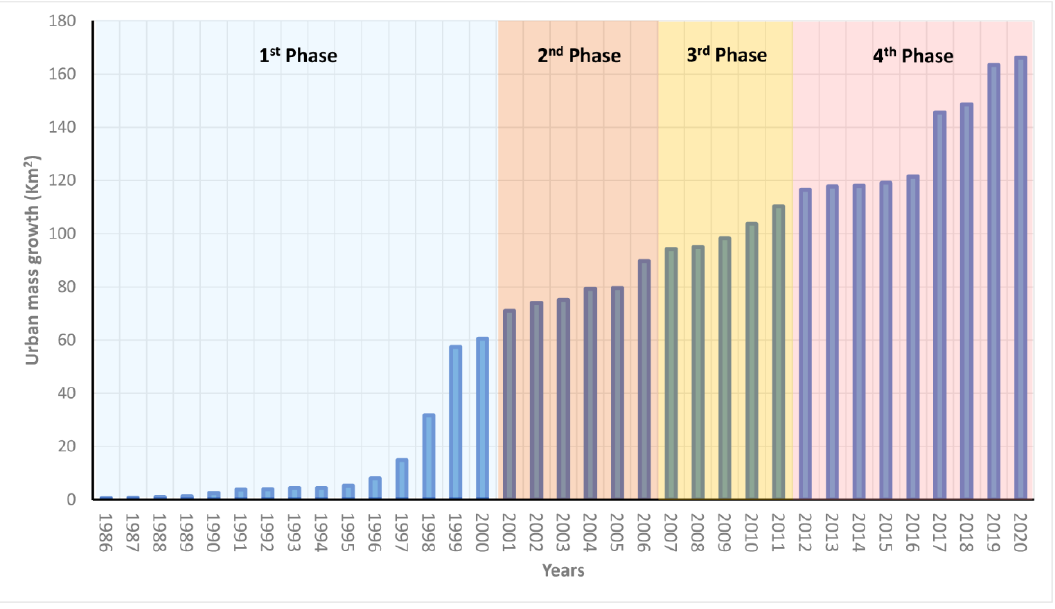
Figure 7. Urban mass growth between 1986 and 2020 per km 2 .